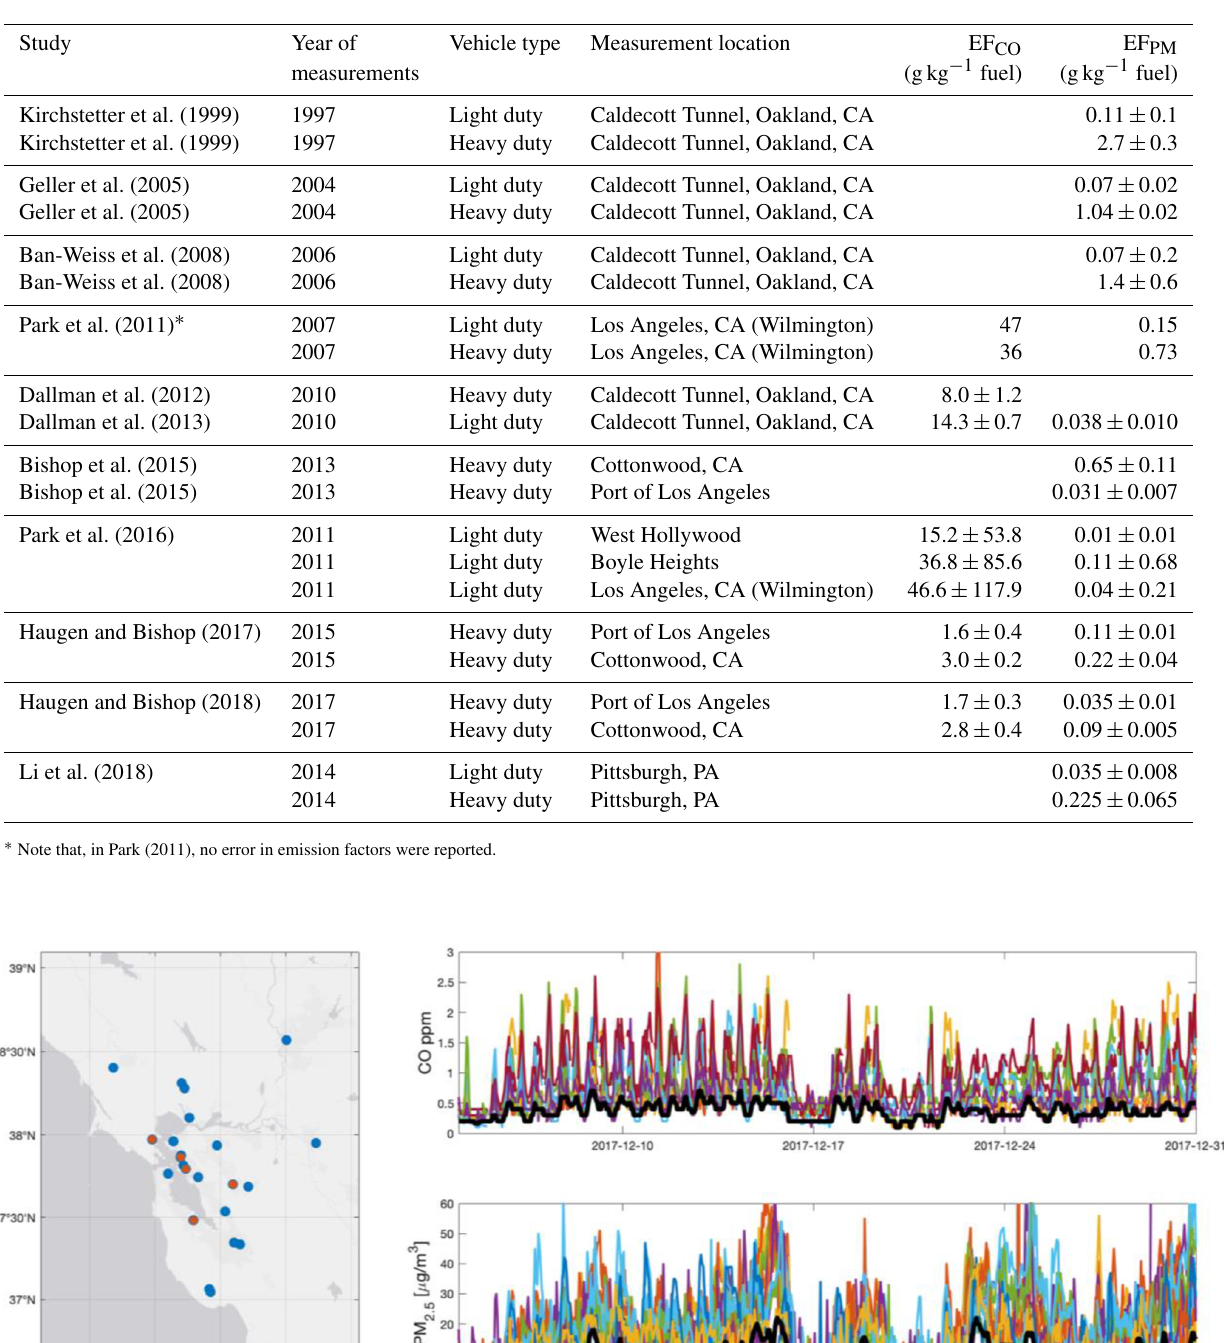
Table 1. Summary of emission factors derived by previous studies.